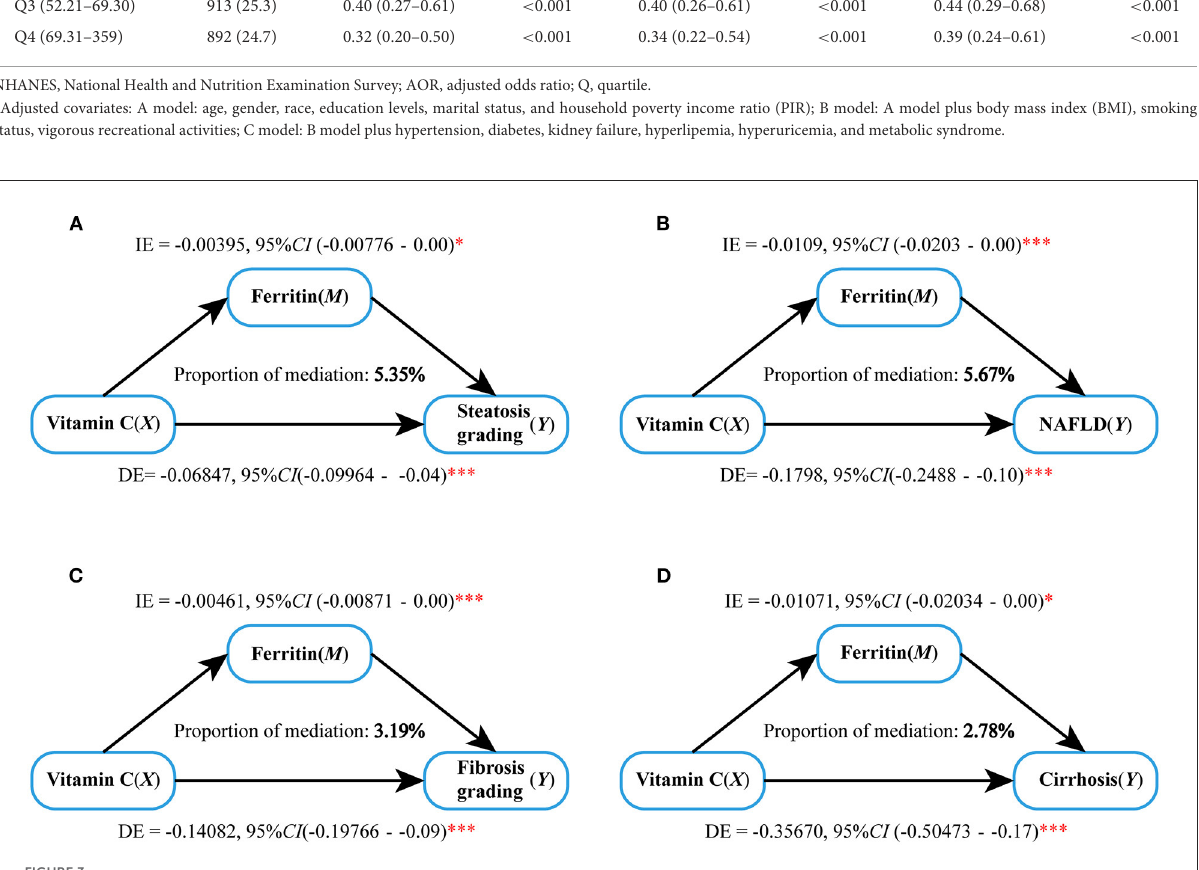
Vitamin C maintains iron homeostasis